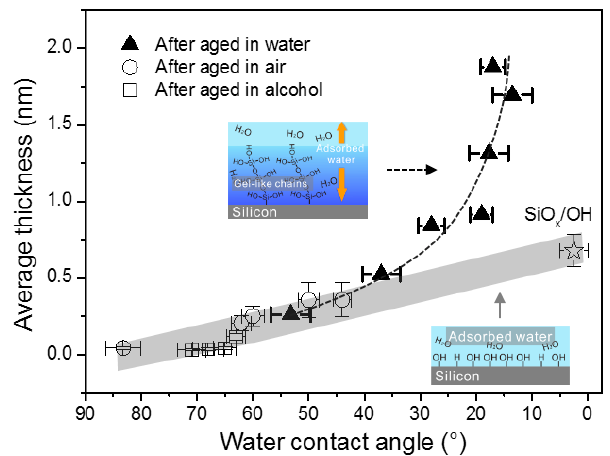
Figure 6. The relationship between adsorbed water thickness and the water contact angle on Si water , Si air , Si alcohol , and SiO x / OH surfaces. Insets: schematic illustrating water adsorption on Si water surface with gel-like chains network formed in DI water (upper) and the transform from hydrophobicity to hydrophilicity (bottom). The gray shadow area and the dashed line are drawn to guide eyes for these two conditions. The RH for all measurements is controlled at 35 ± 5%. Reprinted from Ref. [62].